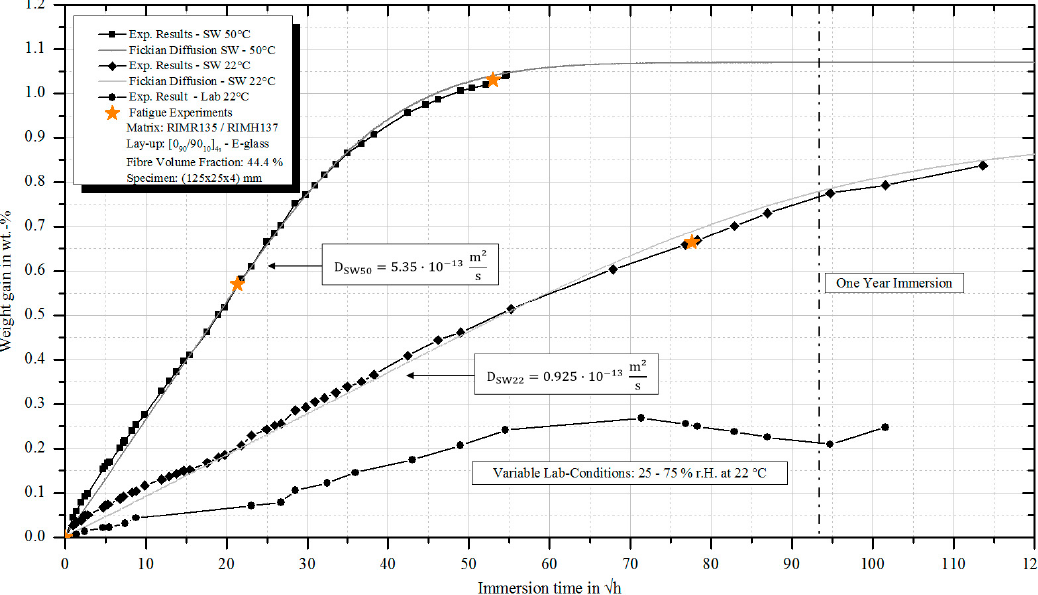
Figure 3. Absorption behaviour of the GFRP specimens at three environmental conditions. Moisture- dependent fatigue testing levels are highlighted with